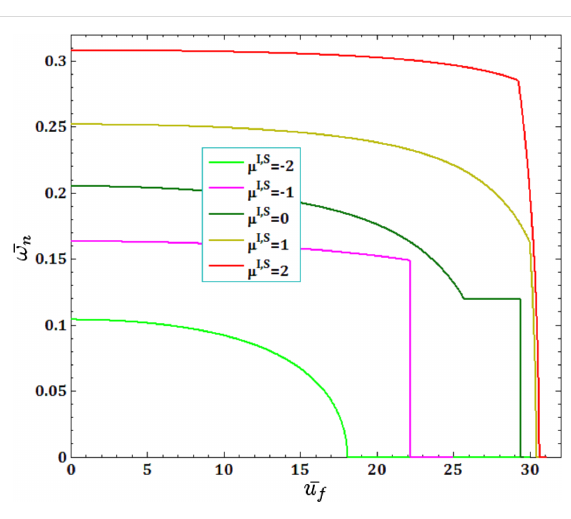
Figure 7: The effects of surface/interface Lame’s constants µ I,S for fluid velocity on DNF of SS FC-MWPENS.